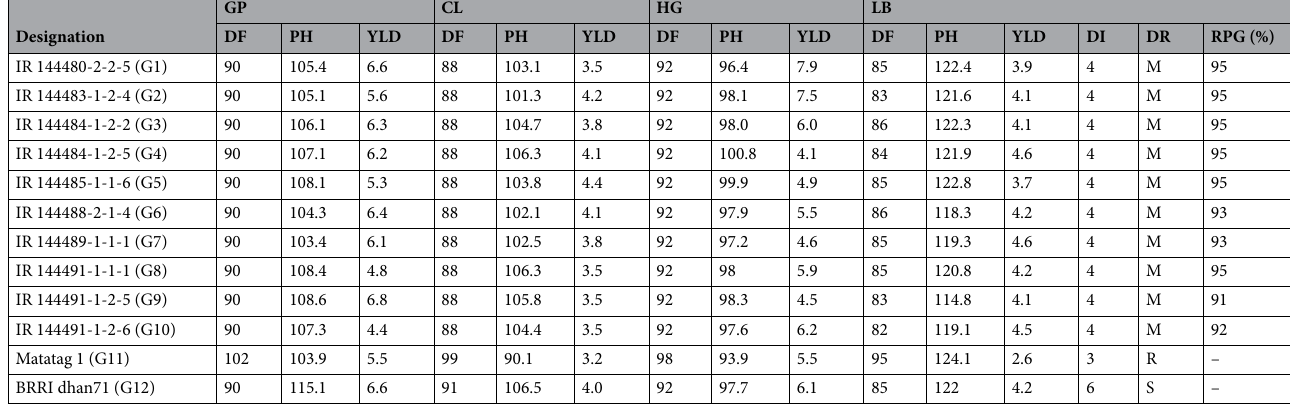
Table 6. Phenotypic performance and disease reaction of selected ILs evaluated at different locations. DF— days to flowering (days), PH—plant height (cm), YLD—yield (t/ha), DI—disease index, DR—disease